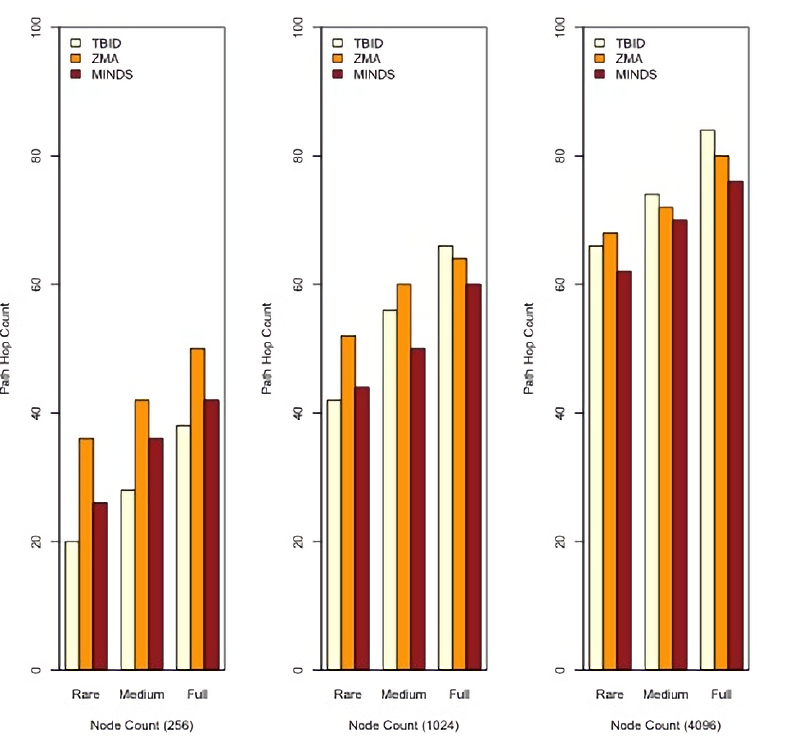
Figure 7. Data collection path